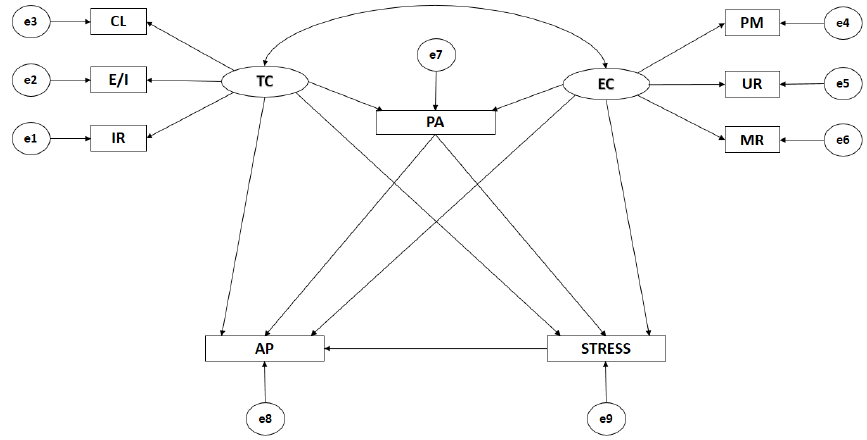
Figure 1. Theoretical Model. Note: TC, task climate; CL, cooperative learning; E/I, effort/improvement; IR, important role; EC, ego climate; MR, member rivalry; PM, punishment of mistakes; UR, unequal recognition; PA, physical activity; AP, academic performance; and STRESS, life stress.